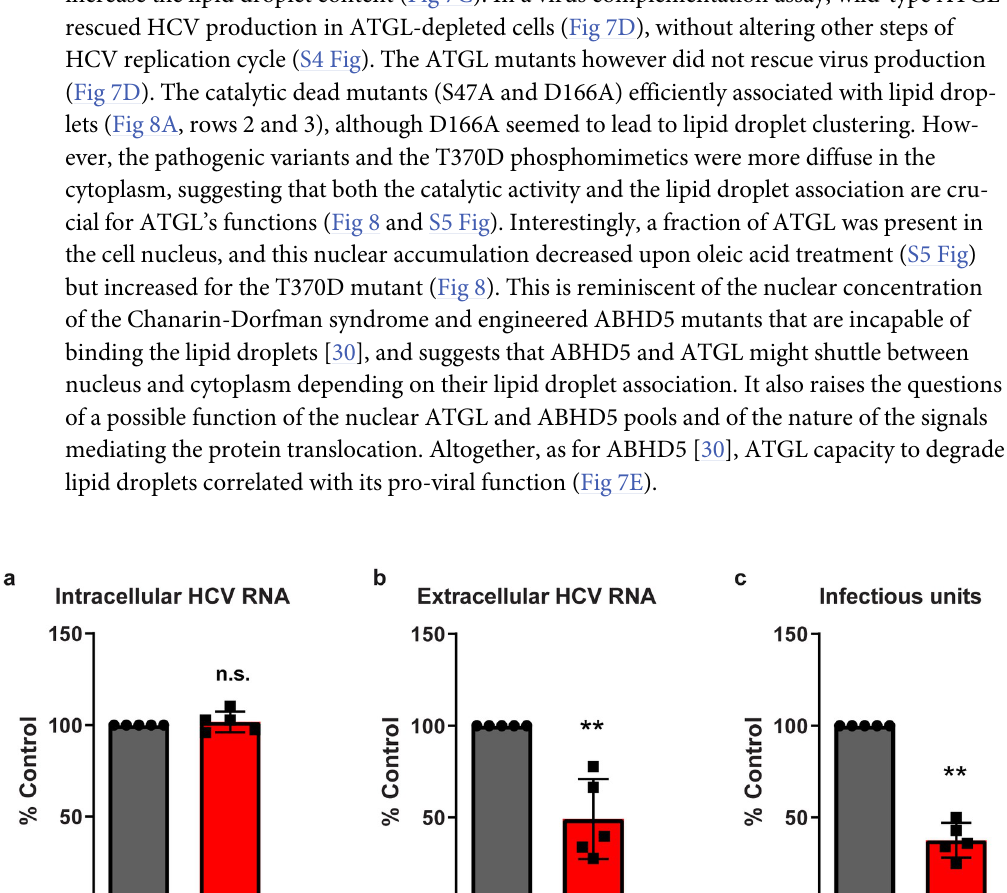
Fig 5. ATGL knockdown induces lipid droplet accumulation and reduces HCV assembly. ( a, b ) Effect of pools of 3 siRNAs targeting ApoE or ABHD5 or 4 siRNAs targeting ATGL (SMARTpool) on HCV replication cycle (n = 3 for 72 hours post-electroporation (h.p.e.) and n = 2 for 96 h.p.e.). Lunet N hCD81 FLuc cells were electroporated with HCV RNA and transfected 4 hours later with the siRNA pools. Panel a represents the effects on the early replication events (RLUs in the producer cells). Panel b depicts the effects on HCV production (RLUs in the target cells normalized by RLUs in the producer cells). For the statistics, we compared the results obtained with the different siRNAs to the average of the negative siRNAs 1 and 2. ( c-g ) Effect of single siRNAs targeting ATGL (si ATGL a, b and c) on ATGL expression, lipid droplet content and HCV replication cycle. ( c ) ATGL mRNA expression was assessed 96 hours (h) post-transfection by qRT-PCR and normalized to GAPDH (n = 2). ( d ) ATGL protein expression was verified by Western blot. The green and red arrowheads point at the ATGL and β -actin protein bands. ( e ) The lipid droplet content of cells transfected with ATGL- specific or control siRNAs was evaluated by flow cytometry at 24-48-72-96 hours post-siRNA transfection. ( f, g ) HCV JcR2a whole replication cycle was examined in the siRNA-transfected cells. ( f ) Entry and replication correspond to the RLuc reading in the producer cells at 48 h.p.i. normalized for the FLuc readings at the same time point, which reflect the cell viability and proliferation (n = 3, except SMARTpool where n = 2). ( g ) Assembly and release values are obtained by normalizing the RLuc readings in the target cells (infected with the 96 h.p.e. supernatants) by the RLuc readings in the producer cells at 48 h.p.e. (n = 4, except SMARTpool where n = 3).